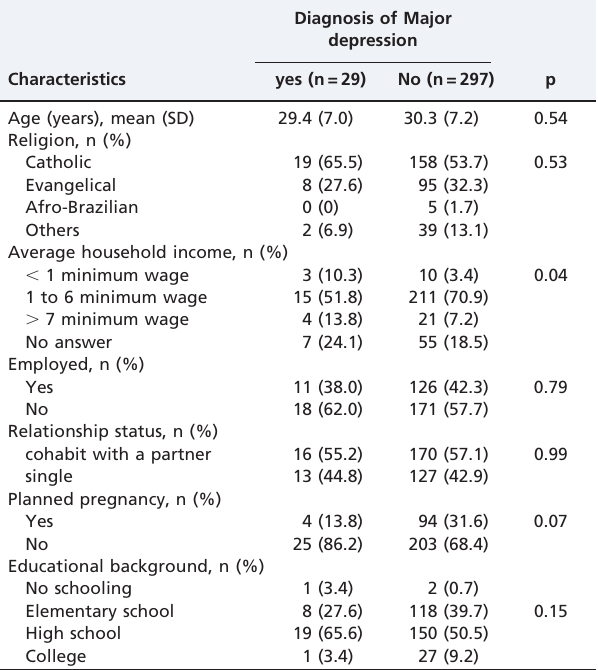
Table 2 - Association of sociodemographic characteristics with a PRIME-MD diagnosis of major depression during pregnancy in women with medical disorders.